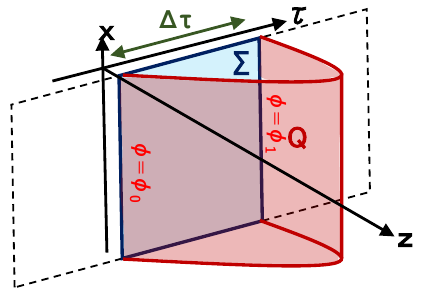
Figure 7 . The setup of AdS 3 / BCFT 2 dual to a BCFT on a strip Σ